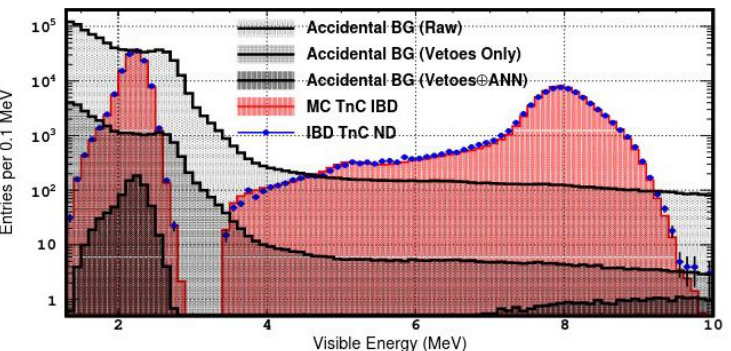
Figure 2. Energy of the delayed signal. The deposited energy by γ ’s from the neutron capture: ∼ 2.2 MeV (H-n), ∼ 5.0 MeV (C-n) and ∼ 8 MeV (Gd-n) is shown in red. The accidental background (grey histogram) is rejected over more than 4 orders of magnitude below 3.5 MeV using vetoes and the neural network (ANN) selection. An excellent data (blue points) to MC (red area) agreement is found in the delayed energy distribution after the rejection